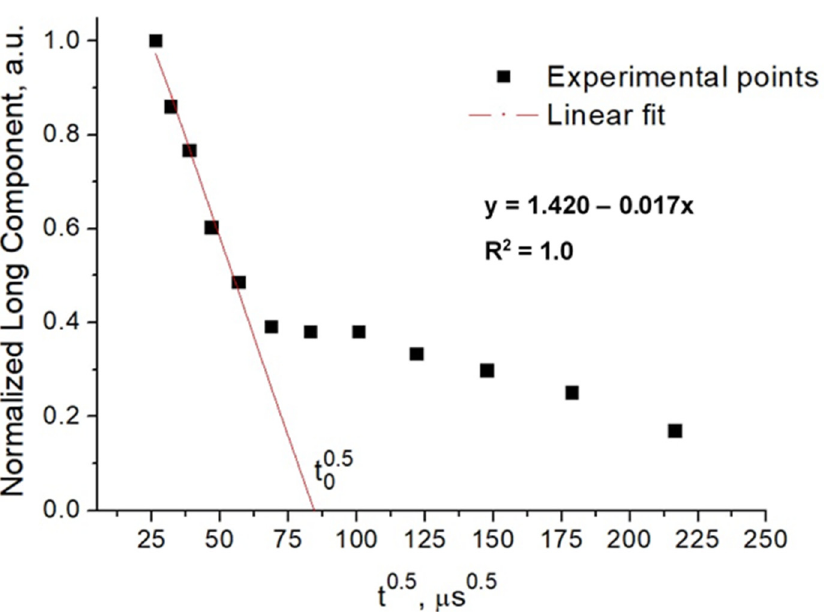
Figure 5. An example of the determination of the parameter t 0.5 in the Goldman–Shen experiment. Table 2. Interface layer thickness of the soft candies calculated by Goldman–Shen pulse sequence.